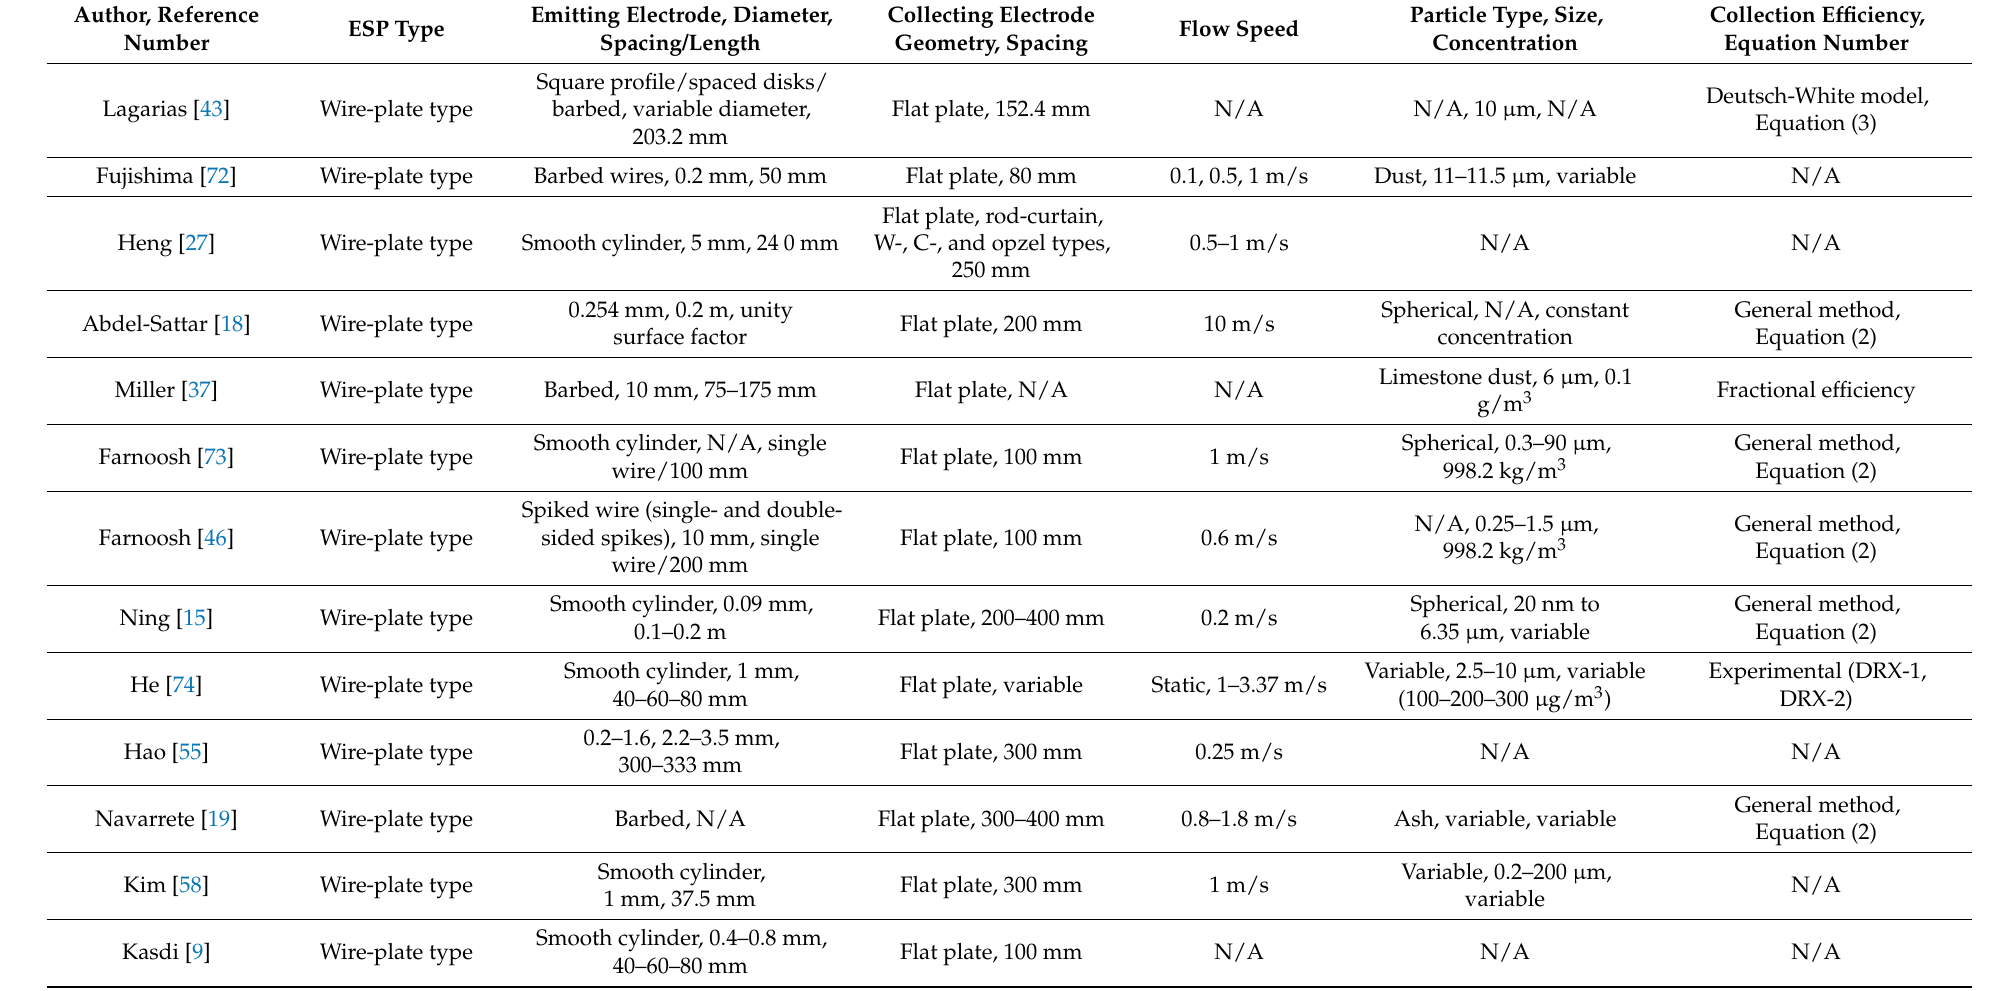
Table 1. Summary of papers evaluating ESP performance based on specific geometric